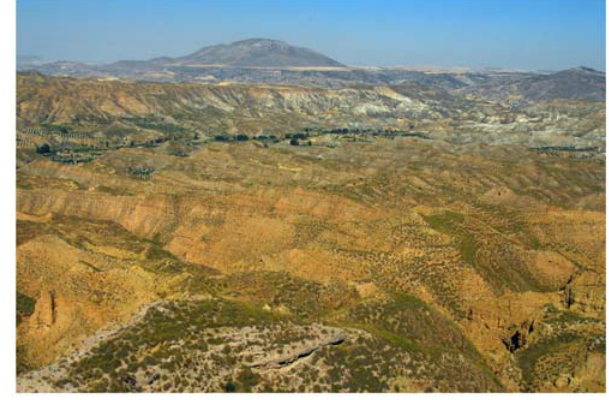
Figure 2. View of the Guadix Basin, to the West (Mencal Hill). Brown rocks belongs to the Internal Transverse System (sterile in mammal fossils); grey and white rocks belongs to the Axial System (units V and VI), fluvial and lacustrine rocks with Pliocene-Pleistocene mammals record.